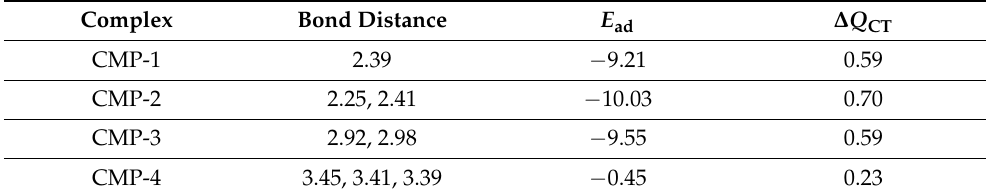
Figure 11. Graphical representation of optimized geometry of AC and Cd (II)@AC complexes. Bond distances are in Å. Table 4. Computed bond distance (Å), adsorption energy ( E ad , eV), and Hirshfeld charge transfer ( ∆ Q CT ,